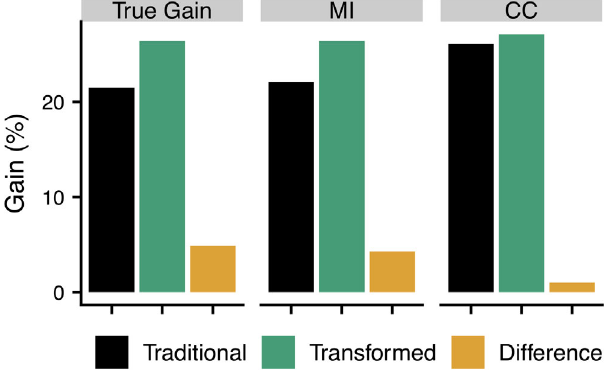
FIG. 11. Bar graph illustrating the effect of bias from complete- case analysis or MI on a comparison of two courses. Performance in both courses was average. The traditional course had a low grade distribution and low participation rates. The transformed course had a high grade distribution and a high participation rate. We did not include error bars to focus on the effects of bias and because they are very small due to the large sample sizes for the simulated